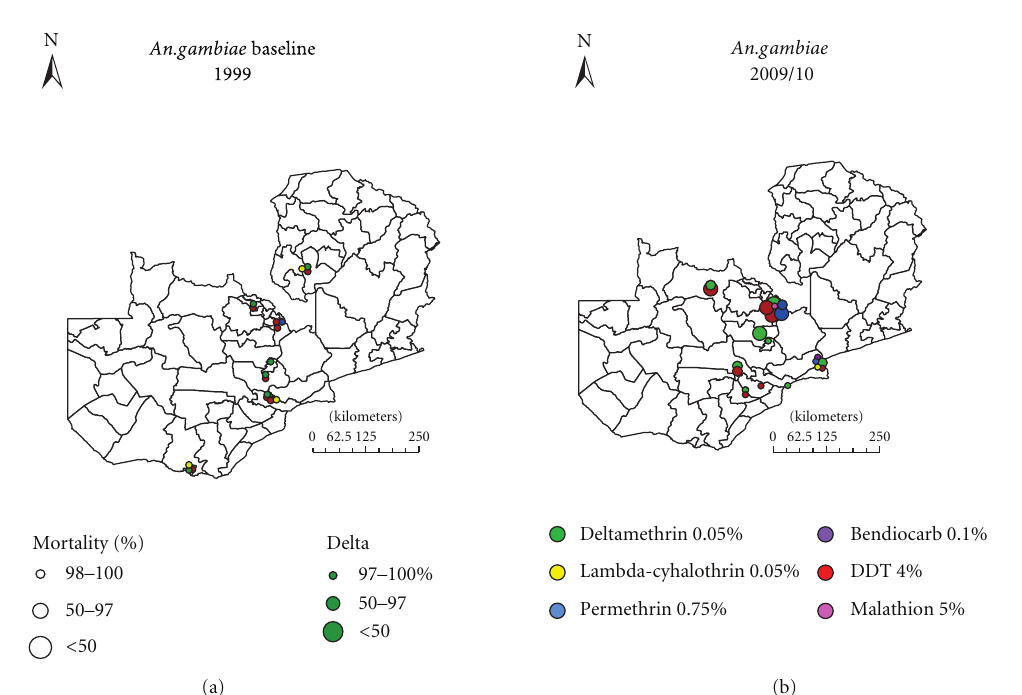
Figure 4: The spatial distribution of insecticide resistance in An. gambiae s.l. in 1999 compared to 2009/10 in Zambia.